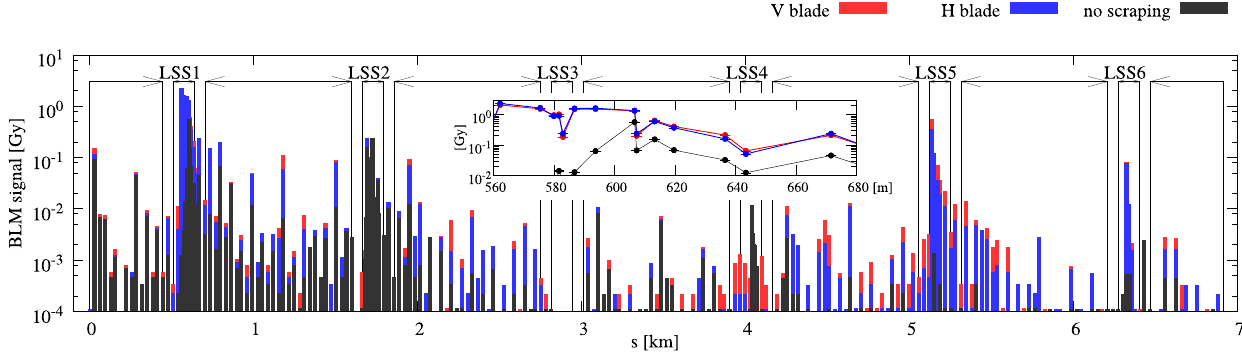
FIG. 8. BLM readouts along the SPS ring recorded during the endurance test of the vertical (red curve) and of the horizontal (blue curve) blades. For comparison, a pattern recorded with beam at full intensity but no scraping is shown as well (black curve) for a dump. The inset focuses on the LSS1 downstream of the BSHV.11759 scrapers under test, located at s ¼ ∼ 560 m.